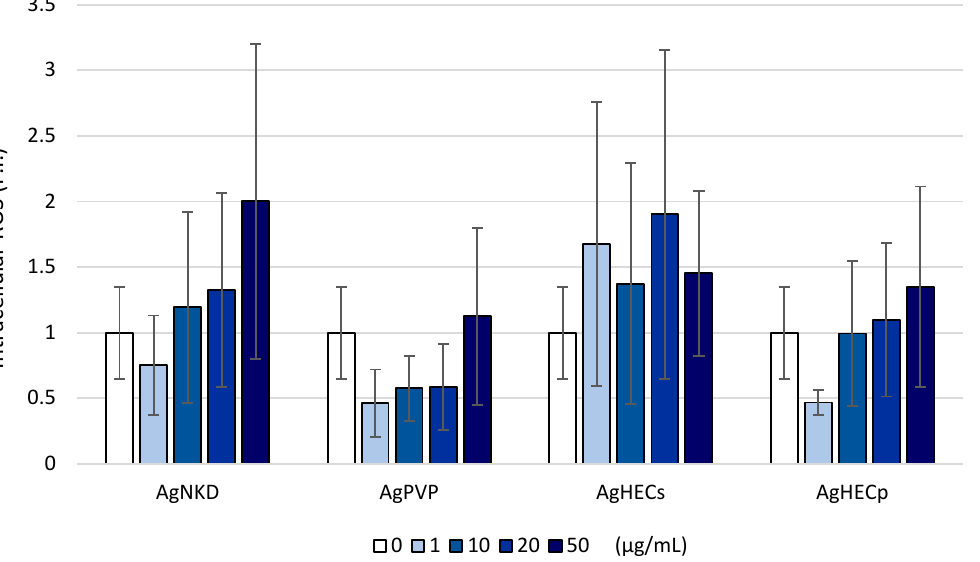
Figure A5. ROS levels in cells exposed to Ag NPs for 24 h. ROS expression was assessed using H 2 DCFDA as indicator although some modulation statistically significant effects were not observed. Data are presented as the mean ± SE. Statistical analysis: one-way ANOVA followed by t -test.